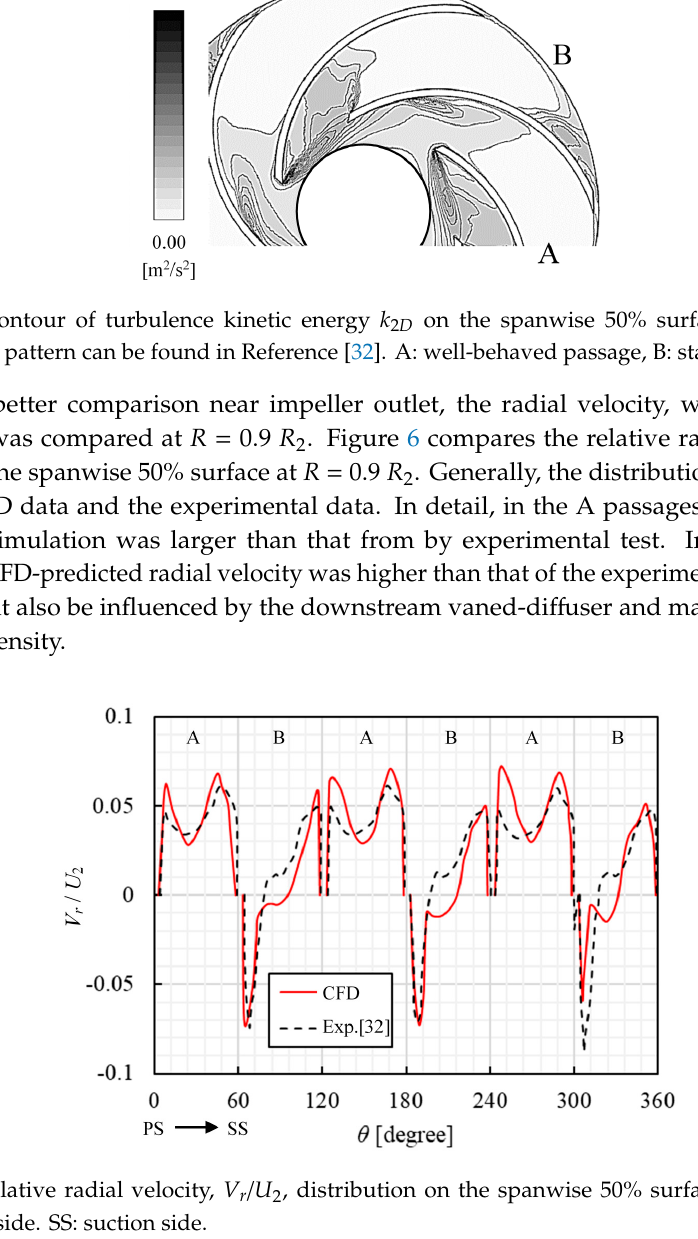
Figure 4. Relative velocity ( V ) vectors on the spanwise 50% surface by CFD, the experimental pattern can be found in Reference [32]. A: well-behaved passage, B: stalled passage.